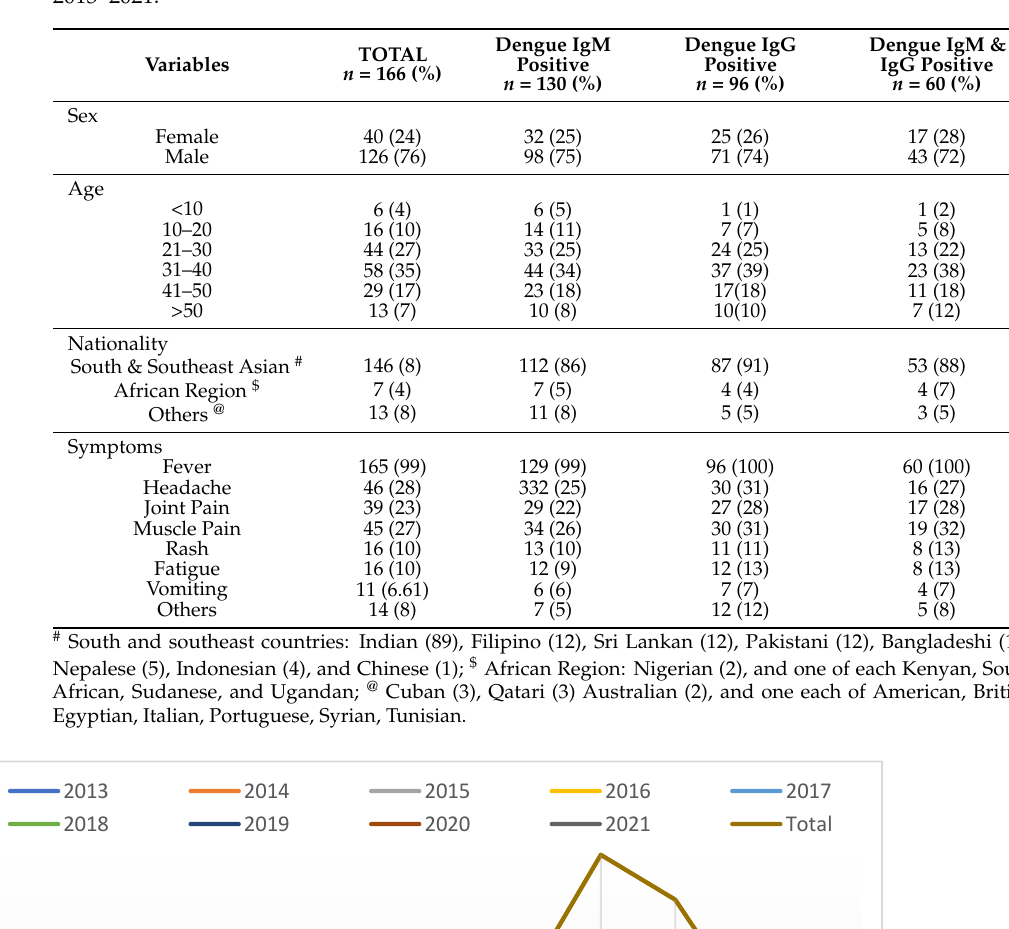
Table 1. Demographic and clinical characteristics of 166 DENV serology confirmed cases in Qatar, 2013–2021.